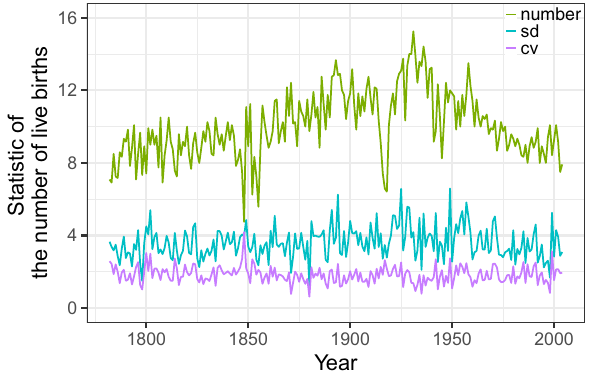
Figure 1. Time series showing that the monthly number of births increased with time until 1931, followed by a decline. The intra-annual standard deviation (sd) in number of births also showed a quadratic association with time, while the intra-annual coefficient of variation (cv, multiplied by a factor 5 for graphical purposes) tended to decrease with time, but both these changes were not statistically significant (Table